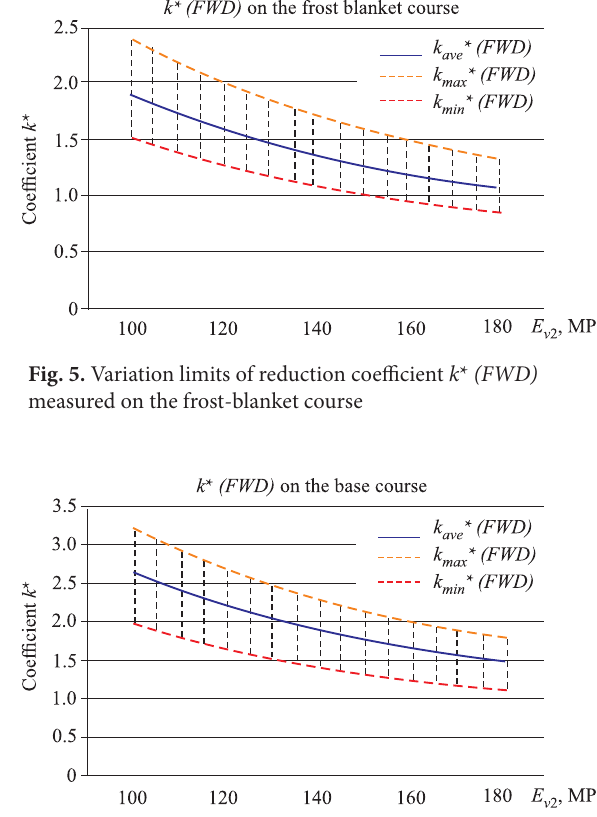
Fig. 6. Variation limits of reduction coefficient k* (FWD) measured on the base